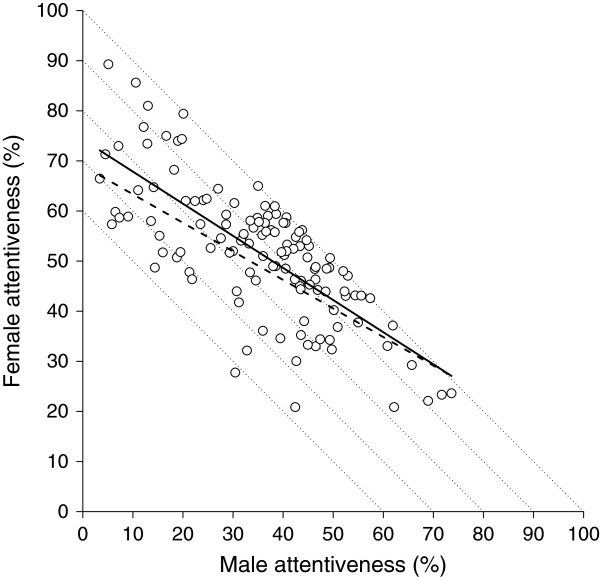
Relationship between female and male attentiveness in species with biparental incubation (N = 124). Full line is ordinary linear regression fit whereas dashed line is phylogenetically corrected fit based on population-level analyses. Dotted lines connect points with identical total nest attentiveness. Inspection of the two regression lines (especially their crossing with dotted lines of equal total attentiveness) suggests that at lower total attentiveness (ca. 70%) female contribution is much higher than male contribution, whereas at higher total attentiveness (ca. 90%) sex-specific contribution is more equal.